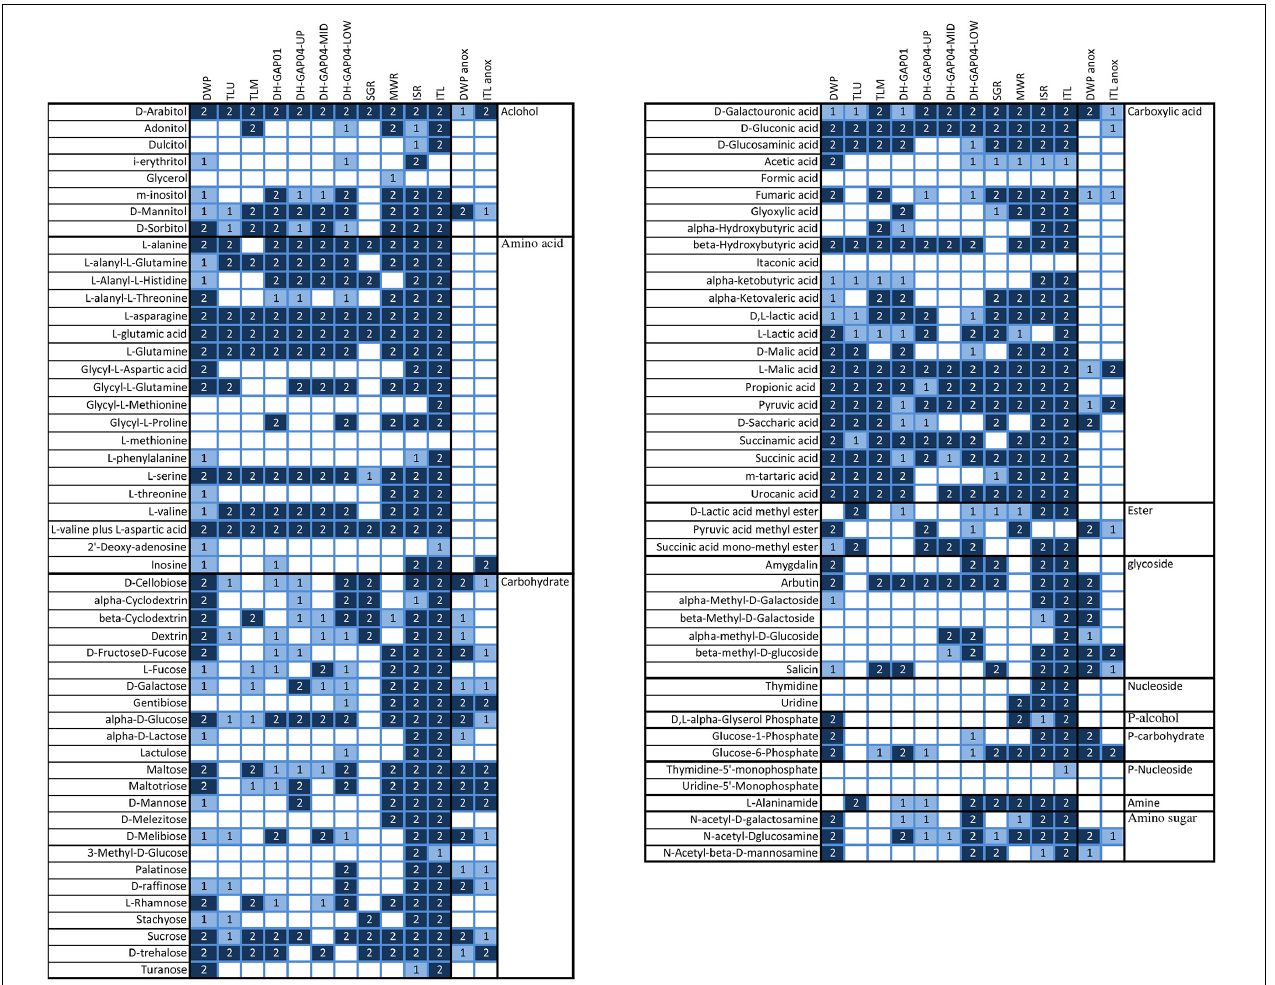
FIGURE 5 | The hydrolysis of substrates on the Biolog AN tests. All tests were done on duplicate test plates. The color coding in the figure indicates whether the hydrolysis occurred on only 1 (light blue) or on both (dark blue) plates. The samples with anaerobic hydrolysis are indicated with